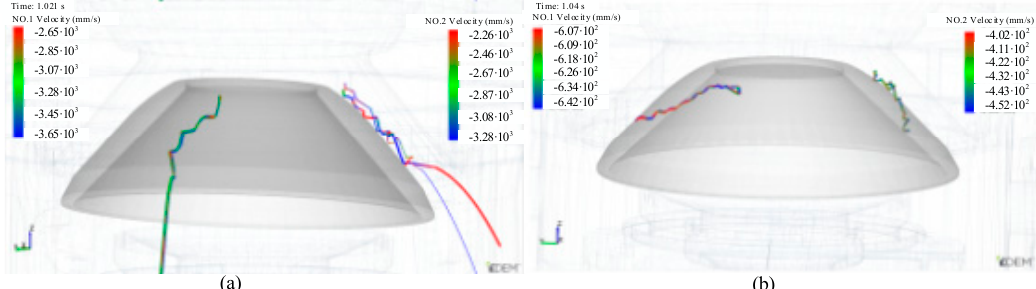
Figure 20. Path trajectory for two breakage particles in the 400 rpm case ( a ) and two breakage particles from the 600 rpm case ( b ).